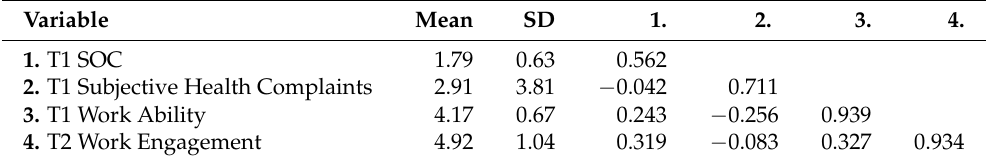
Table 2. Correlations and descriptive statistics for observed